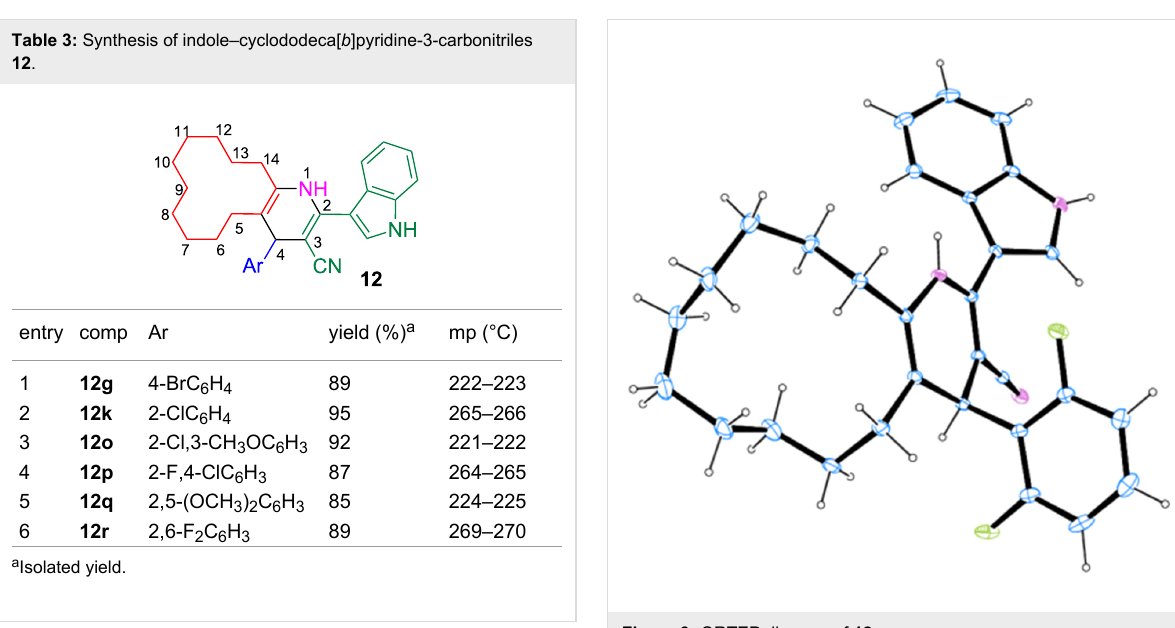
Figure 3: ORTEP diagram of 12r